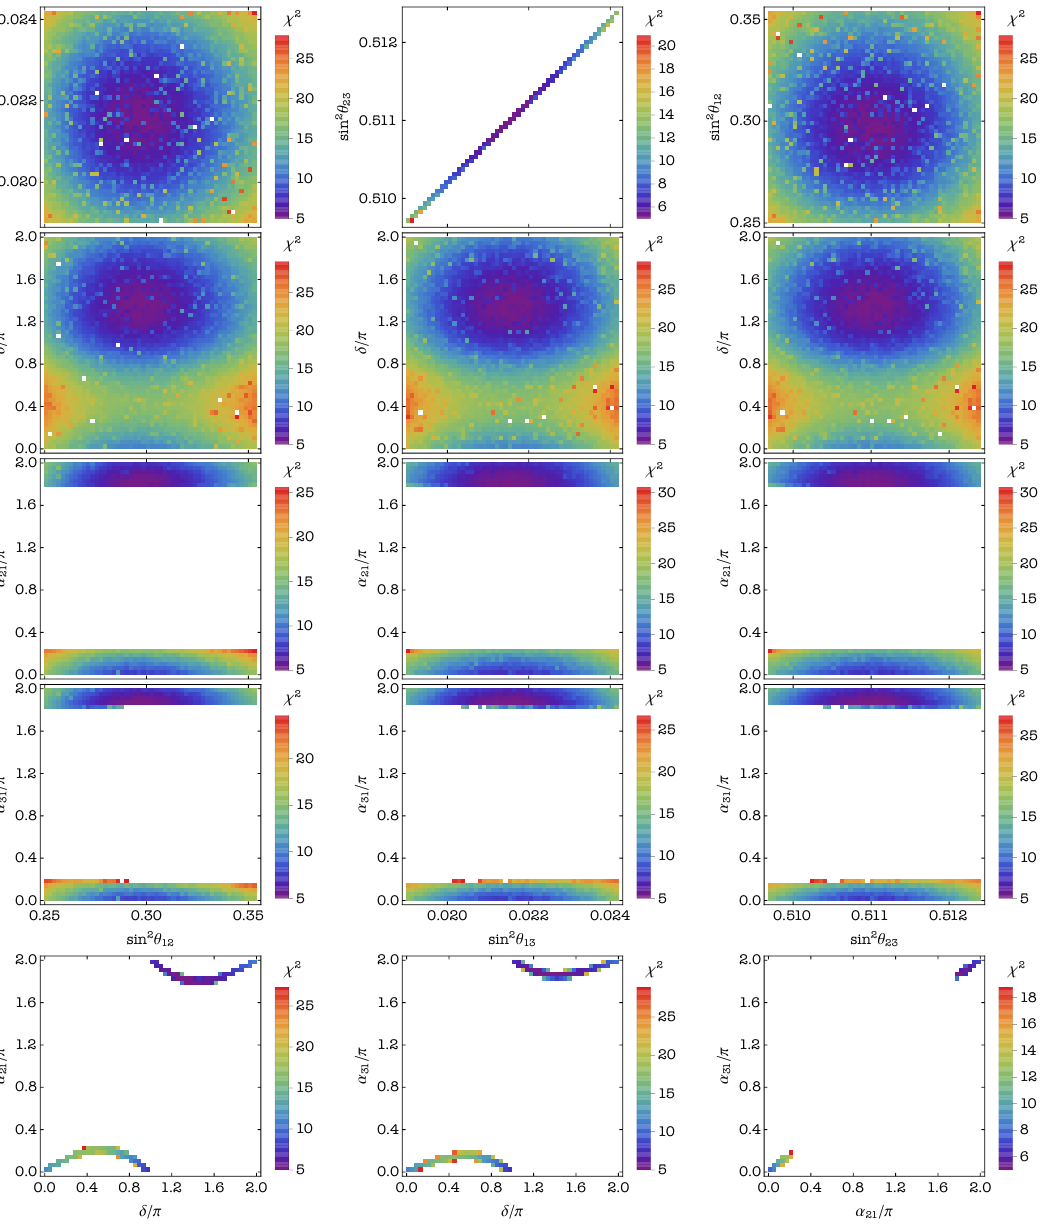
Figure 3 . Correlations between the neutrino mixing parameters in case B3. The values of all the three mixing angles are required to lie in their respective 3 (cid:27) ranges. Colour represents values of (cid:31) 2 for the IO neutrino mass spectrum. Note that this case is not compatible with the 2 (cid:27) range of sin 2 (cid:18) 23